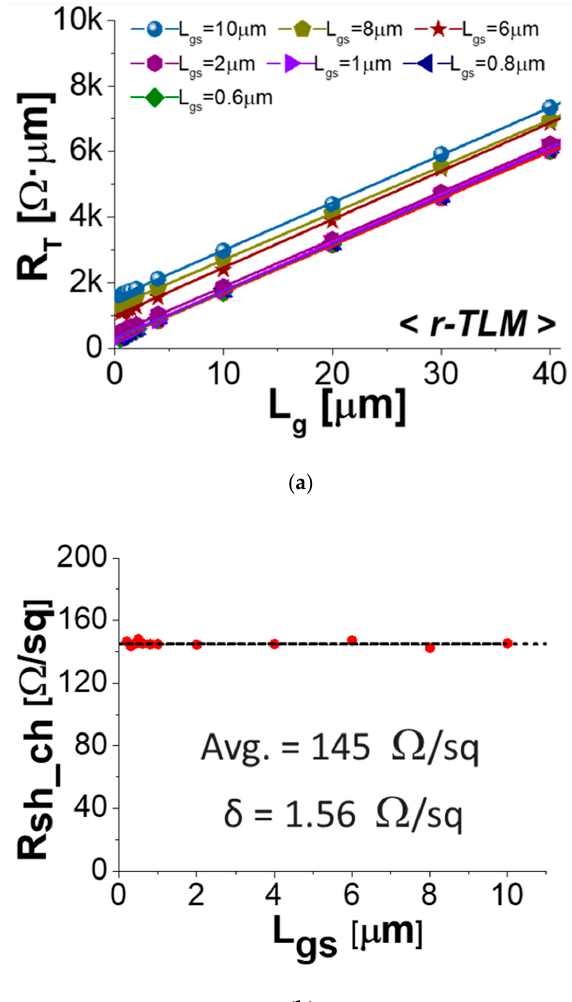
Figure 5. ( a ) Measured total resistance ( R T ) as a function of L g for r-TLM with various dimensions of L gs from 10 μ m to 0.2 μ m, and ( b ) the extracted sheet resistance of the In x Ga 1-x As QW channel ( R sh_ch ) as a function of L gs .